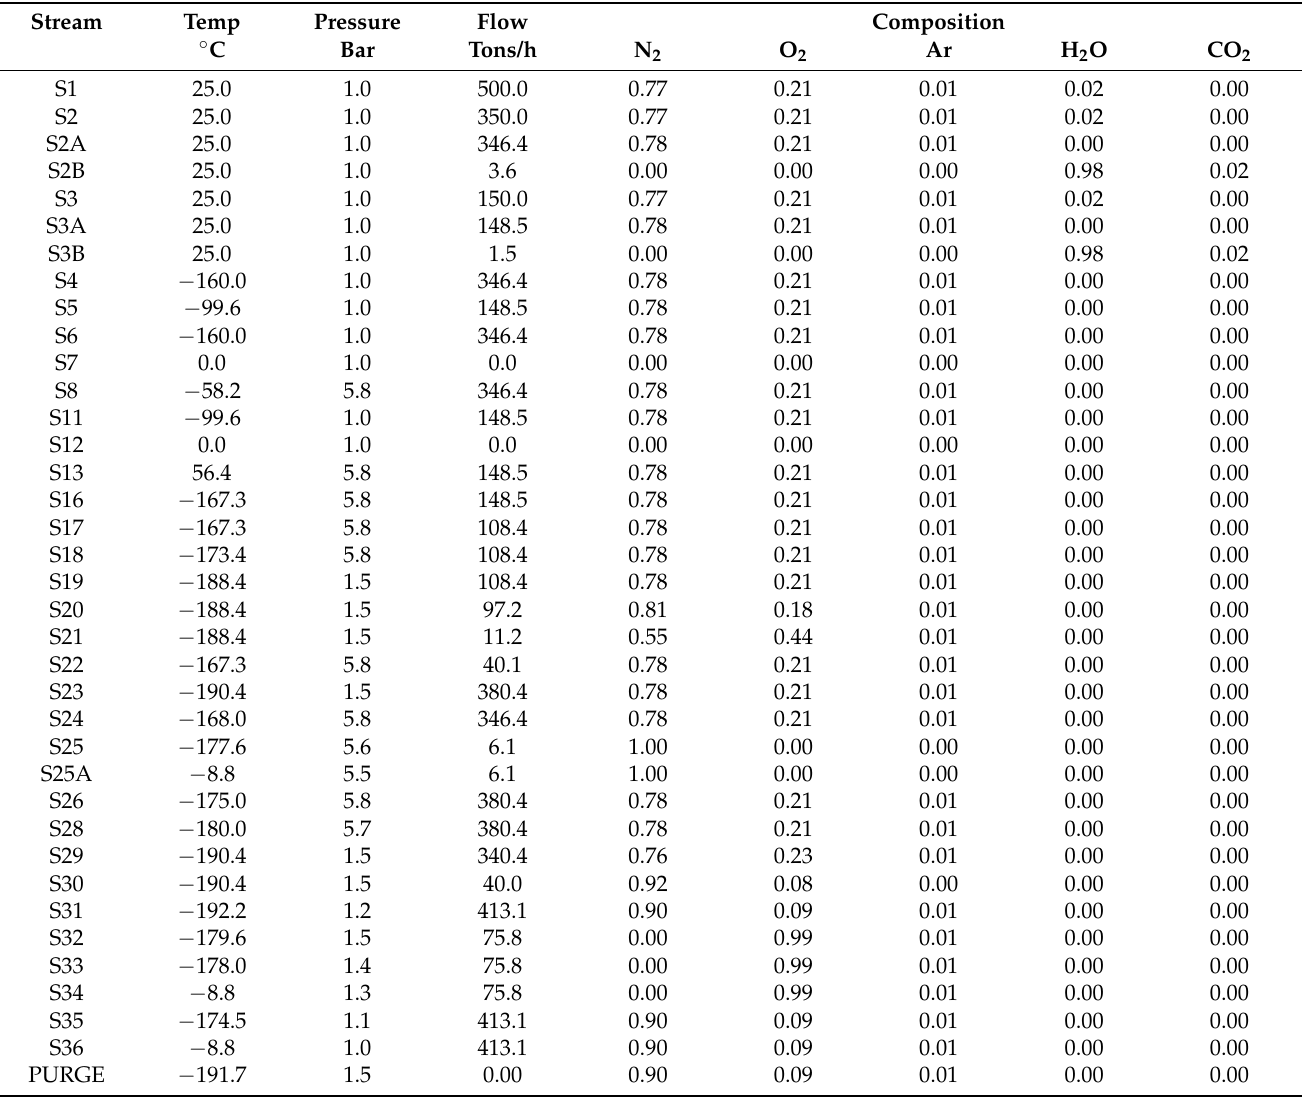
Table 1. Steady-state simulation results for the revised ASU configuration